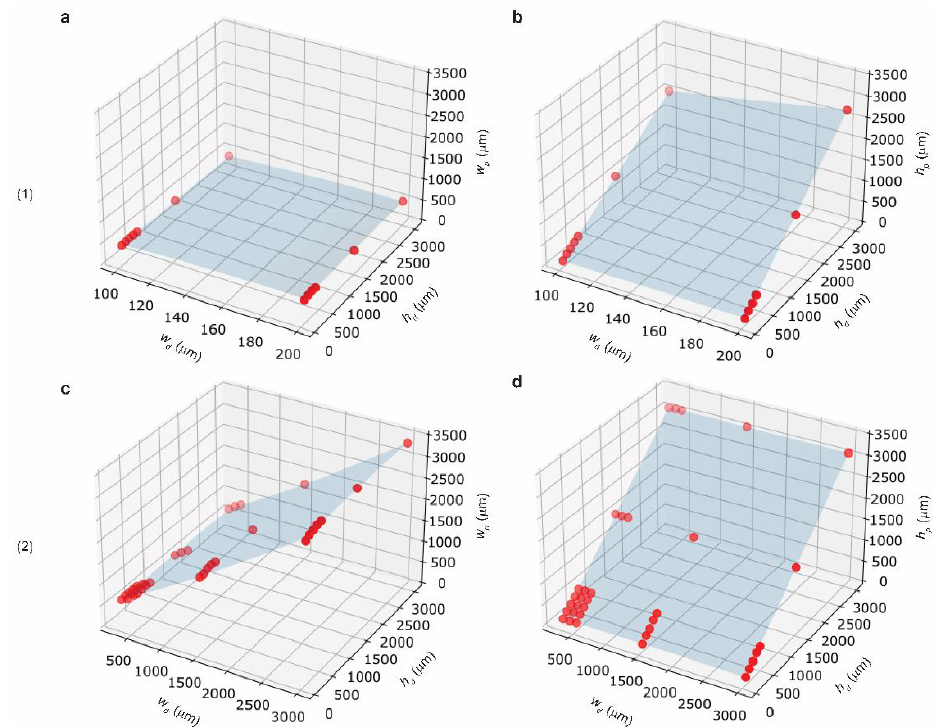
Figure 6. Plots showing the surface fitting of experimental data of HS mode. ( a , b ) represent the modeled surface for w p and h p of low widths. ( c , d ) represent the modeled surface for w p and h p of high